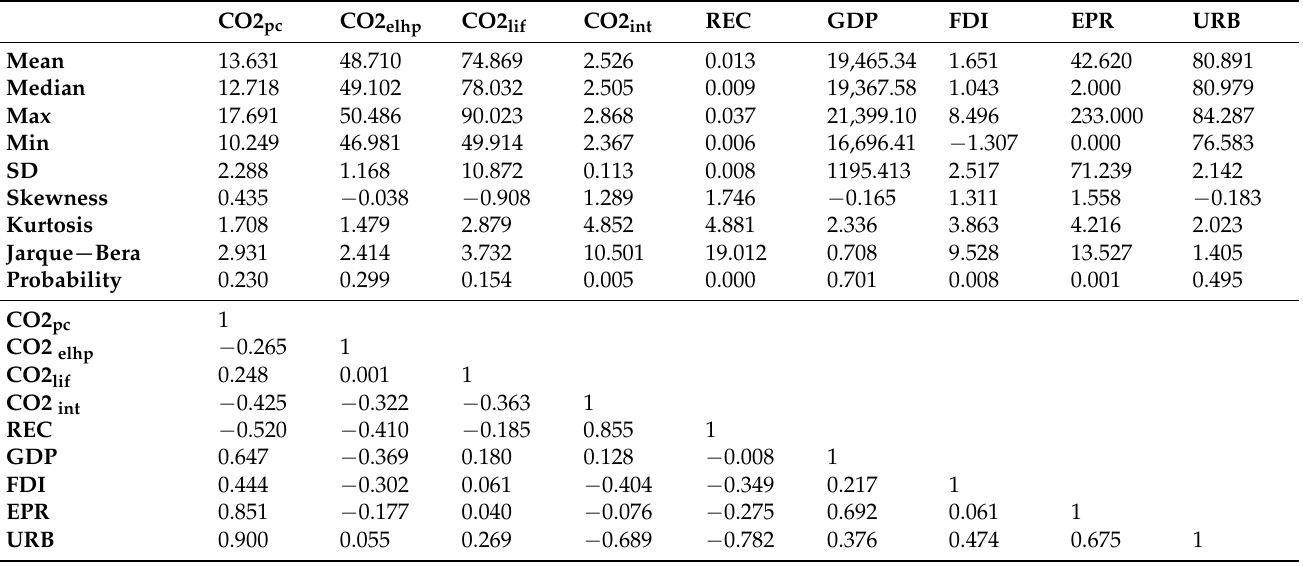
Table 2. Descriptive statistics and pairwise correlations for Saudi